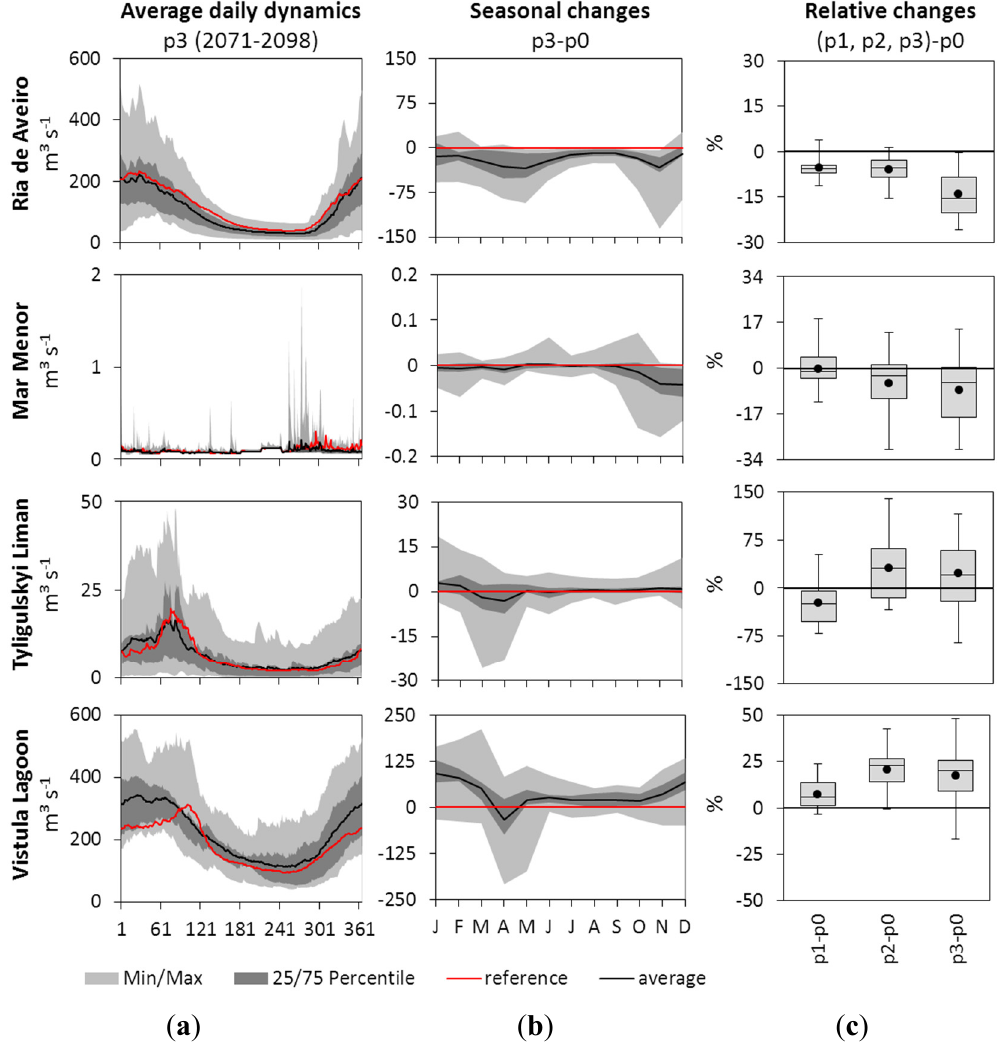
Figure 4. Climate change impacts on total freshwater inflow to the four lagoons with uncertainty ranges simulated by SWIM driven by 15 ENSEMBLES scenarios. ( a ): Long-term average daily dynamics in period p3 (black) with uncertainty ranges (grey) compared to that in the reference period (red); ( b ): Differences in long-term monthly dynamics between periods p3 and p0 (black) with uncertainty ranges (grey) and zero line (red); ( c ): Spread of 15 long-term average annual changes for three future periods compared to the reference period of the same scenario. Each box plot visualizes the min/max, 25/75-percentiles, median (line) and average (dot) of 15 average changes. The dynamics for Tyligulskyi Liman are shown without the outlying scenario